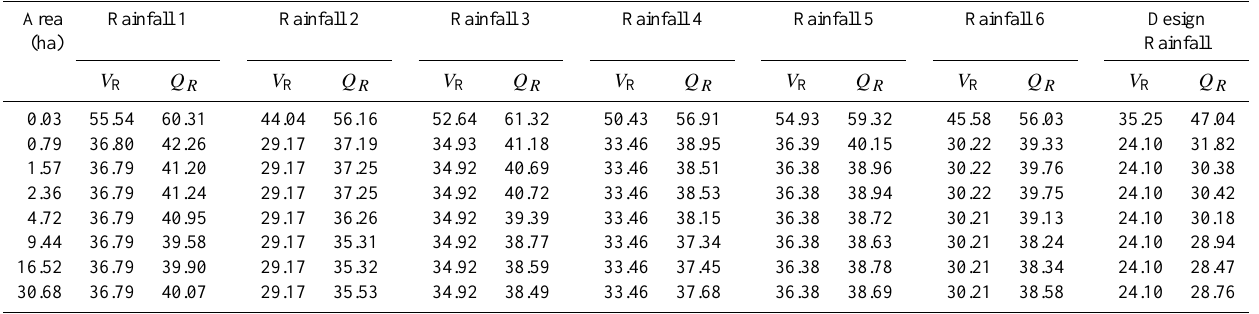
Table 3. Volume reduction ( V R ) and peak flows ( Q R ) in each drainage area for the seven events (%). Area Rainfall 1 Rainfall 2 Rainfall 3 Rainfall 4 Rainfall 5 Rainfall 6 Design (ha) Rainfall V R Q R V R Q R V R Q R